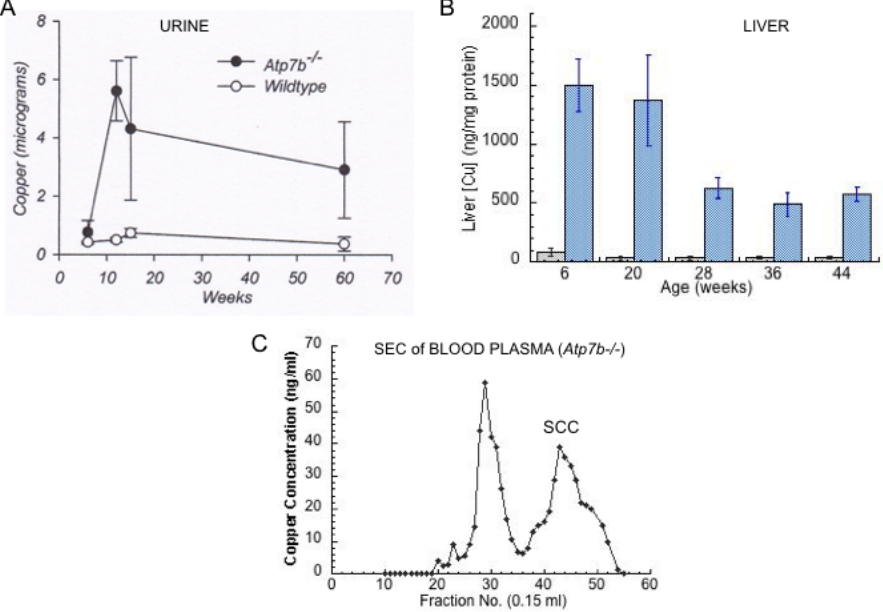
Figure 7. Cu in livers, urine and blood plasma of wild type (Control) and Wilson disease (Atp7b-/-) model mice. Elevations of urinary Cu ( A ) and liver Cu ( B ) (blue vs. grey bars) in the Atp7b-/- mice vs. wild type, and evidence for the presence of large amounts of low molecular weight Cu in the blood plasma ( C ) seen in Superdex 200 size exclusion chromatography (SCC, fractions 40–50). Figure A reprinted with permission, from Gray et al. [93]; data in B replotted from those in Table 1 of Huster et al. [94]; data in C are from Miguel Tellez, Abigael Muchenditsi, Svetlana Lutsenko, and Maria C. Linder, unpublished.